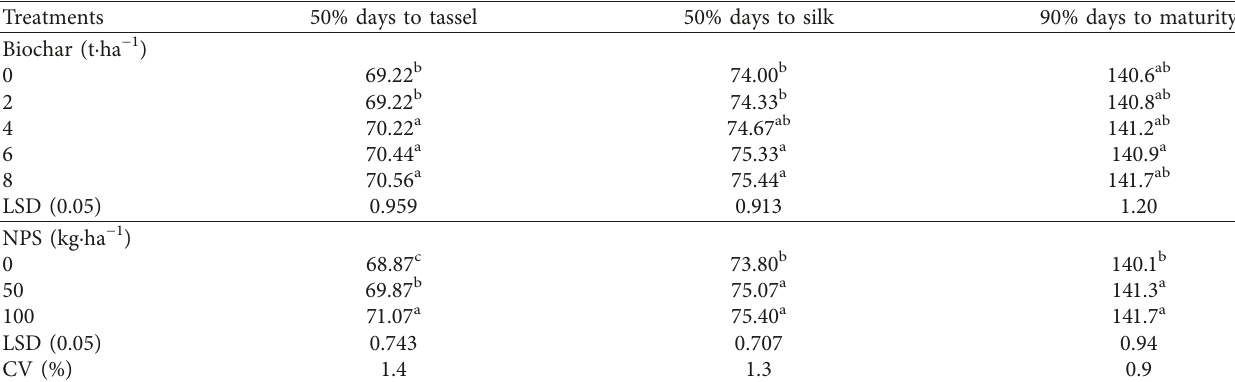
Table 3: The main effect of biochar levels and inorganic NPS fertilizer rates on number of days to 50% days to tassel, number of days to